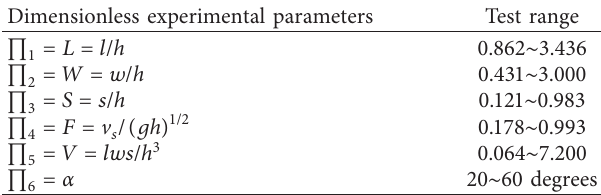
Table 2: Overview of experimental